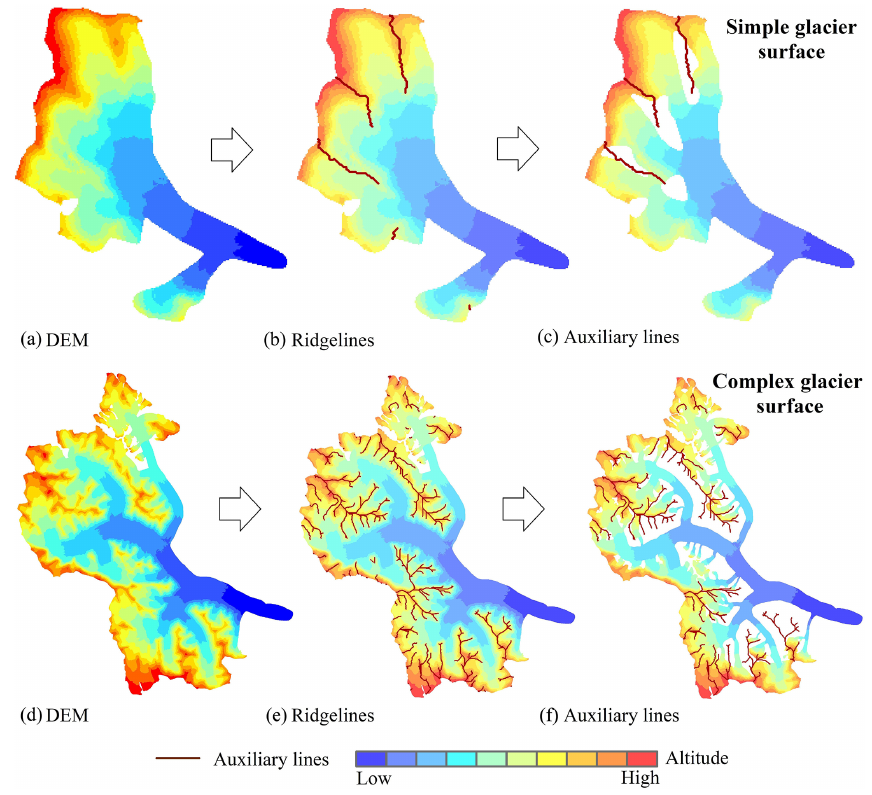
Figure 4. The schematic of extracting auxiliary lines. Panels (a and d) demonstrate the digital elevation model (DEM) around the glacier. Panels (b and e) show the ridgelines in the region covered by the DEM. Panels (c and f) show the auxiliary lines in the